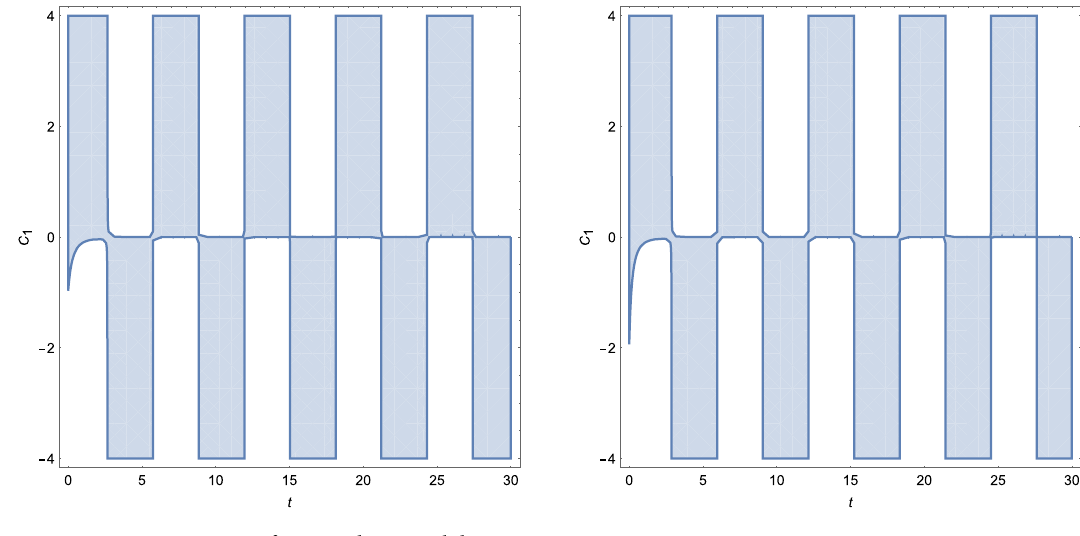
Figure 8. Regions of NEC and WEC validity.